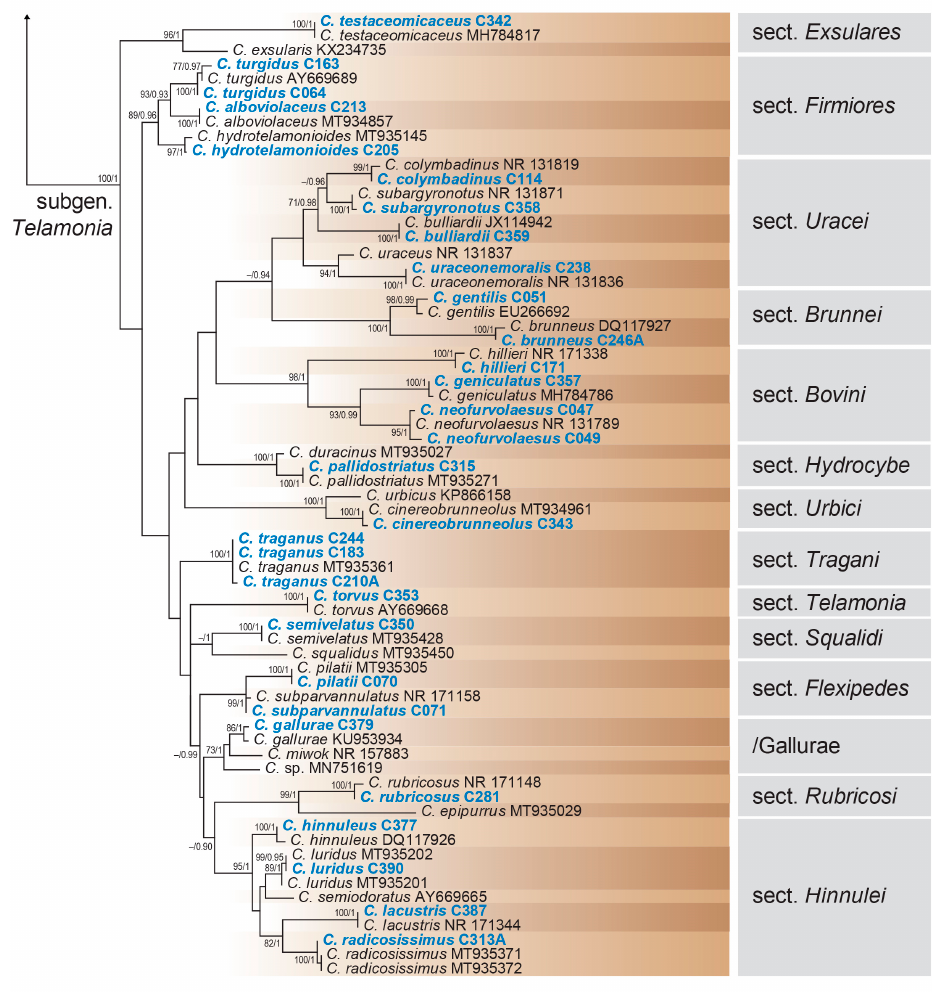
Figure 3. Maximum likelihood phylogenetic tree of the dermocyboid, leprocyboid, rozitoid, telamonioid, and myxacioid sections/clades of the genus Cortinarius s.l. based on nrDNA ITS sequence analyses with gap coding. Sequences produced in this study are in blue and boldface and labelled with their voucher numbers. Sequences from public repositories are marked with their GenBank/UNITE accession numbers. ML bootstrap values of >70% as well as Bayesian posterior probabilities of >0.9 are placed above or below branches. The scale bar indicates 0.03 expected change per site per branch.